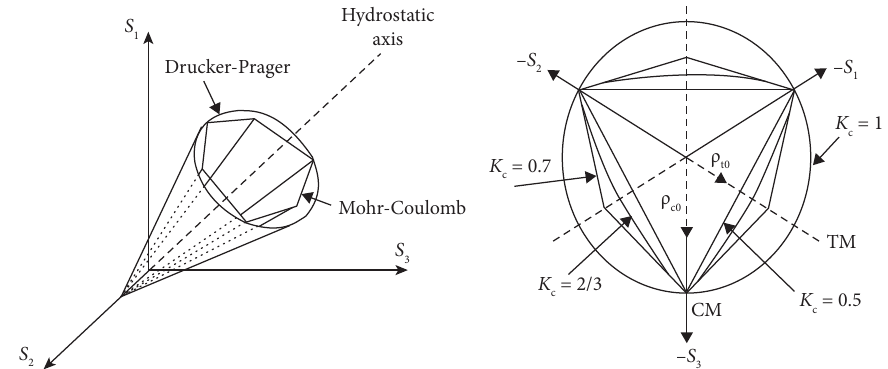
Figure 1: Tree deviatoric sections of the concrete failure criterion [22].